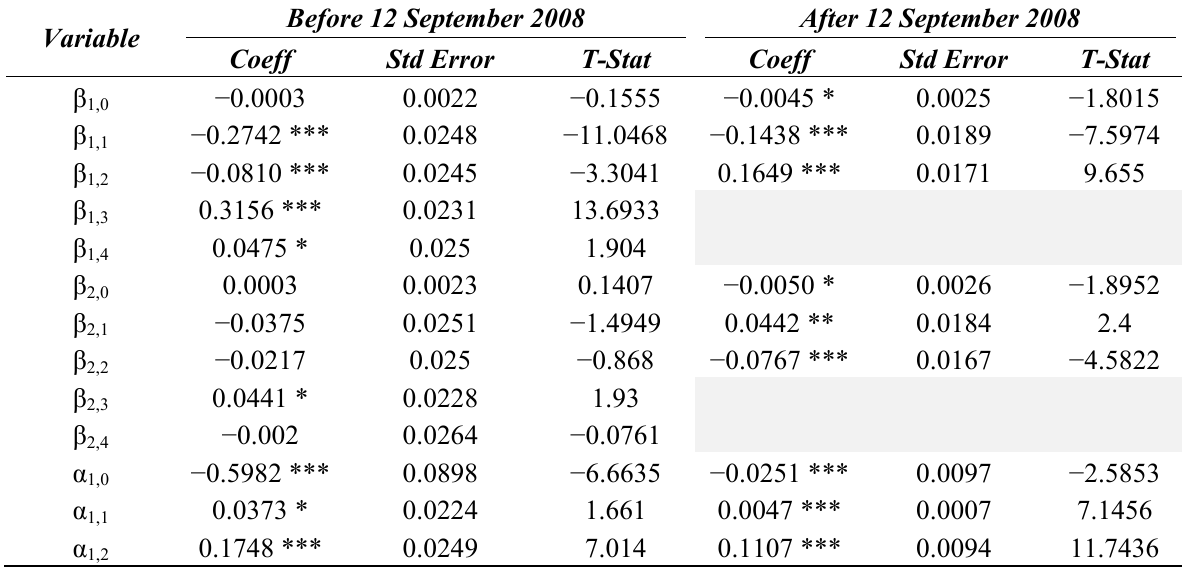
Table 4. VAR (2) EGARCH (1,1) CAC 40 DAX 30